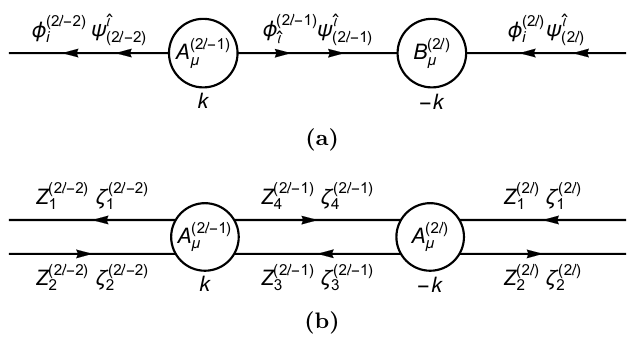
Figure 10. The quiver diagram of N = 4 orbifold ABJM theory in (a) ABJM notations and (b) N = 2